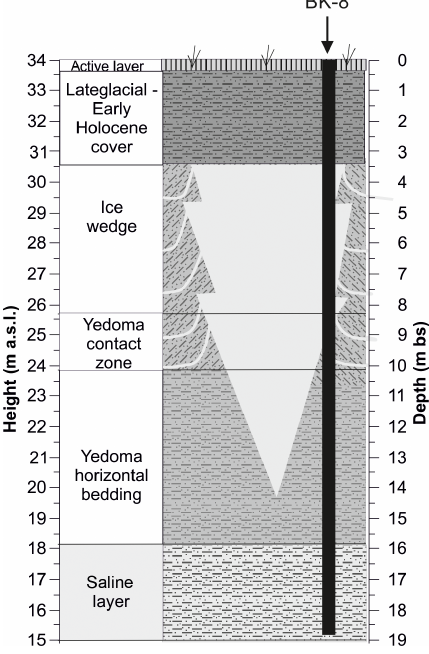
Figure 7. Scheme of the BK-8 permafrost core including the main cryolithological units. The legend is given in Figs. 3 and